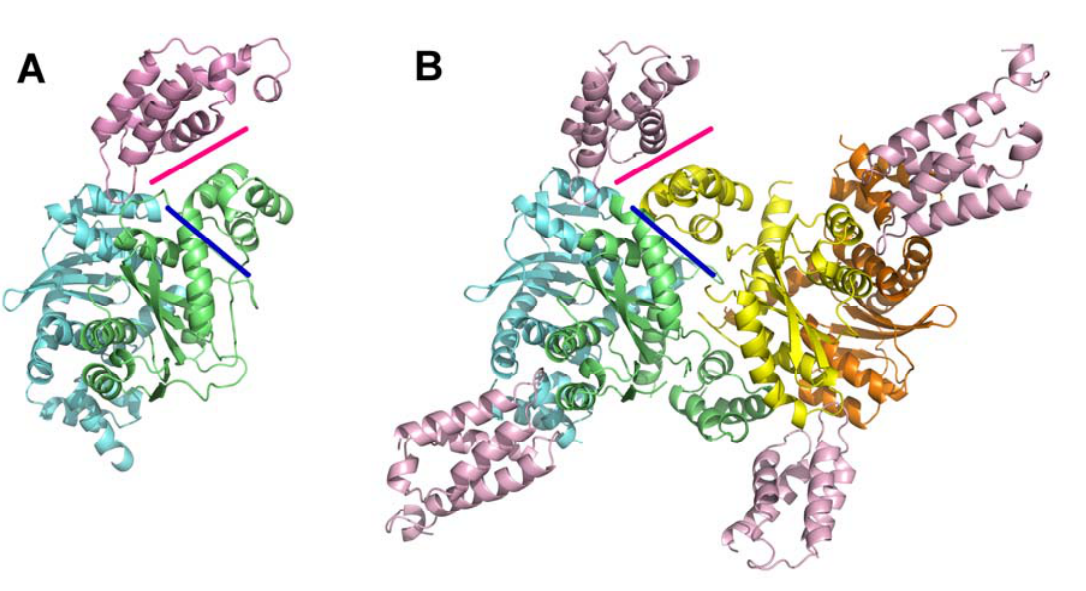
Figure 6. The structural basis for IN tetramerization. A. The crystal structure of the dimeric HIV-2 IN construct in complex with LEDGF (PDB ID 3f9k). The NTD+CCD IBD intramolecular NTD:CCD interface is shown as a blue line and the IBD:NTD interface as a pink line. B. The crystal structure of tetrameric MVV IN in complex with NTD+CCD LEDGF (PDB ID 3hph). The NTD-CCD interface (blue line) is conserved from the IBD dimeric HIV-2 structure, although, as a consequence of NTD swapping, in the tetrameric structure this interface is intermolecular. Charge-charge interactions between the IN NTD and LEDGF IBD (pink line) act to stabilize the tetramer thereby explaining the observed effect of LEDGF on IN multimerization in vitro